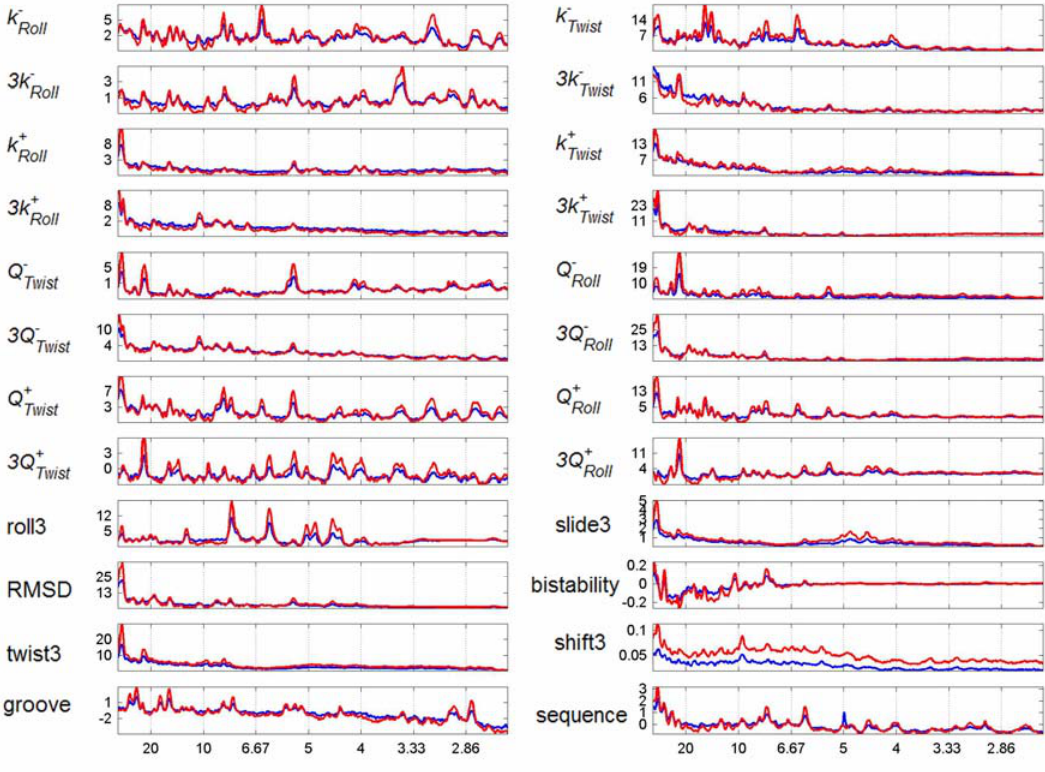
Figure 2. Whole Chromosome Difference Spectra. Mean power spectra of chromosome 21 less mean power spectra of randomised chromosome 21 (blue line), Mean power spectra of chromosome 22 less mean power spectra of randomised chromosome 22 (red line), for selected structural properties. In each case the y-axis is the difference divided by